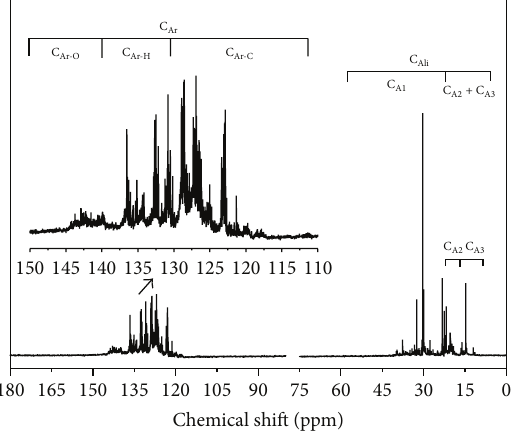
Figure 5: 13 C-NMR spectra of asphaltene.